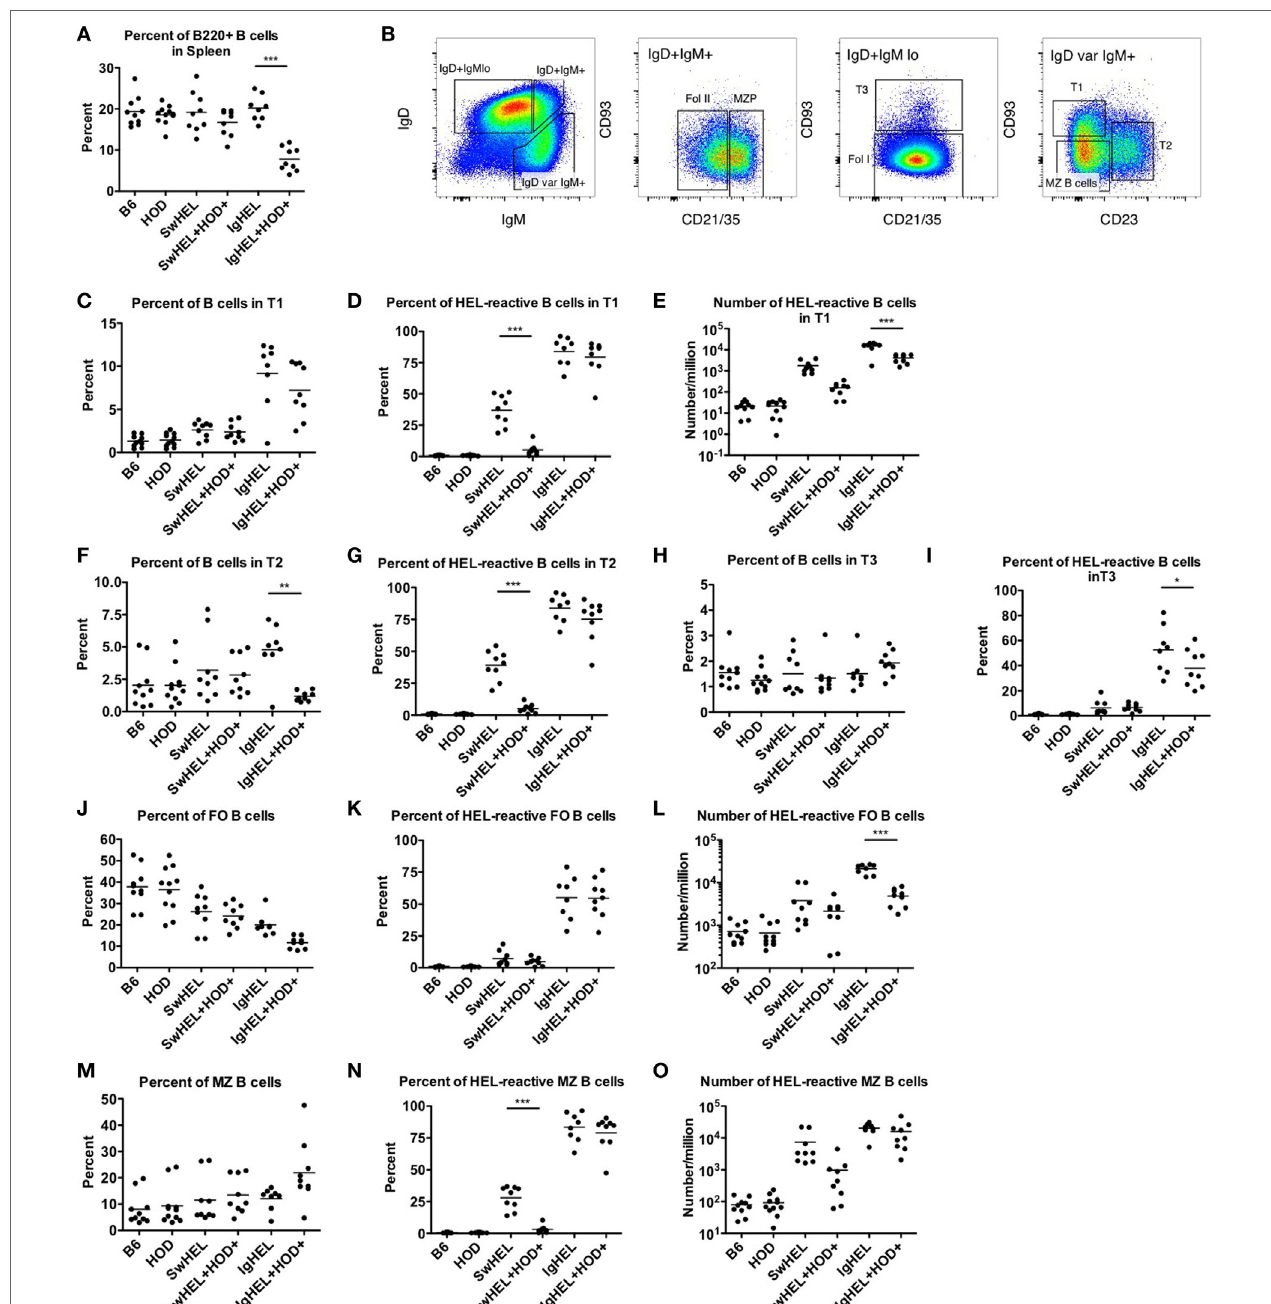
FigUre 3 | Effect of red blood cell autoantigen on B cell transition and maturation. Splenocytes were harvested from mice and stained with antibodies against IgD, IgM, CD93, CD21/35, CD23, and B220 to define the stages of B cell development in the spleen. To evaluate reactivity to hen egg lysozyme (HEL), cells were stained with albumin-tet to control for nonspecific binding followed by HEL-tet. (a) The percentage of B220 + splenic B cells was determined and (B) the stages of B cell maturation was outlined. The (c) percentage of B cells, (D) frequency, and (e) absolute number of HEL-reactive B cells was computed for transitional stage 1 (T1). The (F) percent and (g) number of HEL-reactive B cells was assessed for transitional stage 2 (T2). Similarly, the percent of (h) total B cells and (i) HEL-reactive B cells was determined for transitional stage 3 (T3). Likewise, the (J) percentage of FO B cells, and (K) frequency, and (l) number of HEL-reactive mature FO B cells were evaluated. The (M) percent of MZ B cells was calculated and HEL-reactive MZ B cell (n) percentages and (O) numbers were determined. Flow plots in (B) are representative data from three independent experiments with at least three mice per group. Scatter dot plots in (a) and (c–O) are compiled data from three independent experiments with at least three mice per group. Selective p values are shown on graphs and * ≤ 0.05, ** ≤ 0.01, and *** ≤ 0.001. For complete statistical analysis with all significant differences, see Table S3 in Supplementary